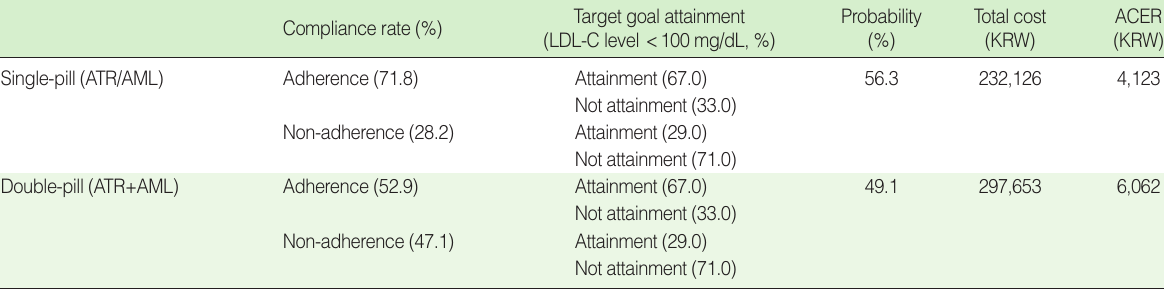
Table 3. Average cost-effectiveness ratios